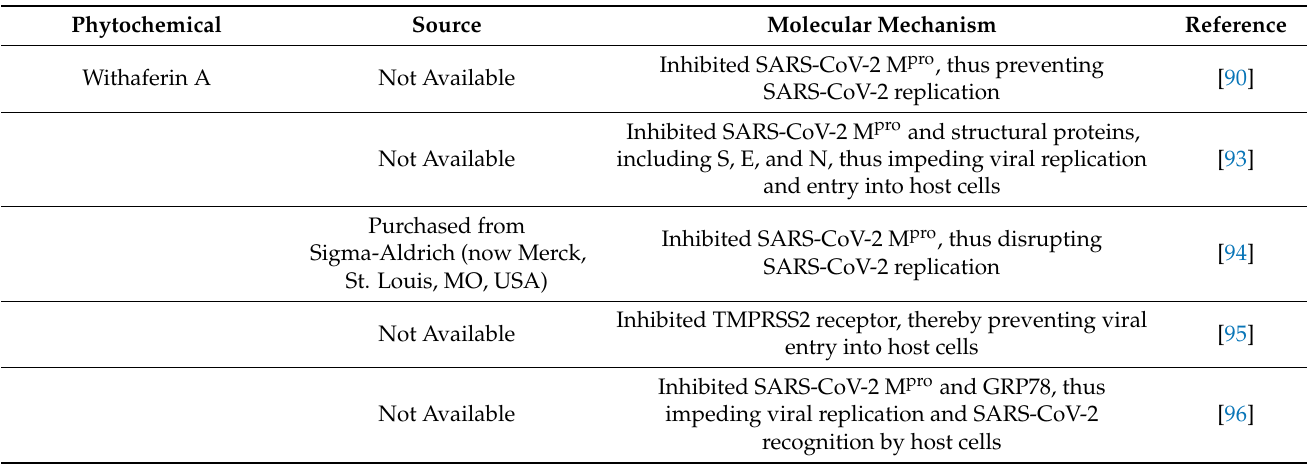
Figure 5. The structure of Withania Somnifera phytochemicals. The key phytochemicals of Withania somnifera include Withaferin A, Withanolide A, Withanolide B, Withanolide R, 2,3-Dihydrowithaferin A, Withanone, Withanoside IV, Withanoside V, Withanoside X, Quercetin glucoside, and Somniferin, which might exhibit SAR-CoV-2 inhibitory activity. Table 2. Withania somnifera and its phytochemicals and associated molecular mechanisms of their therapeutic effects against